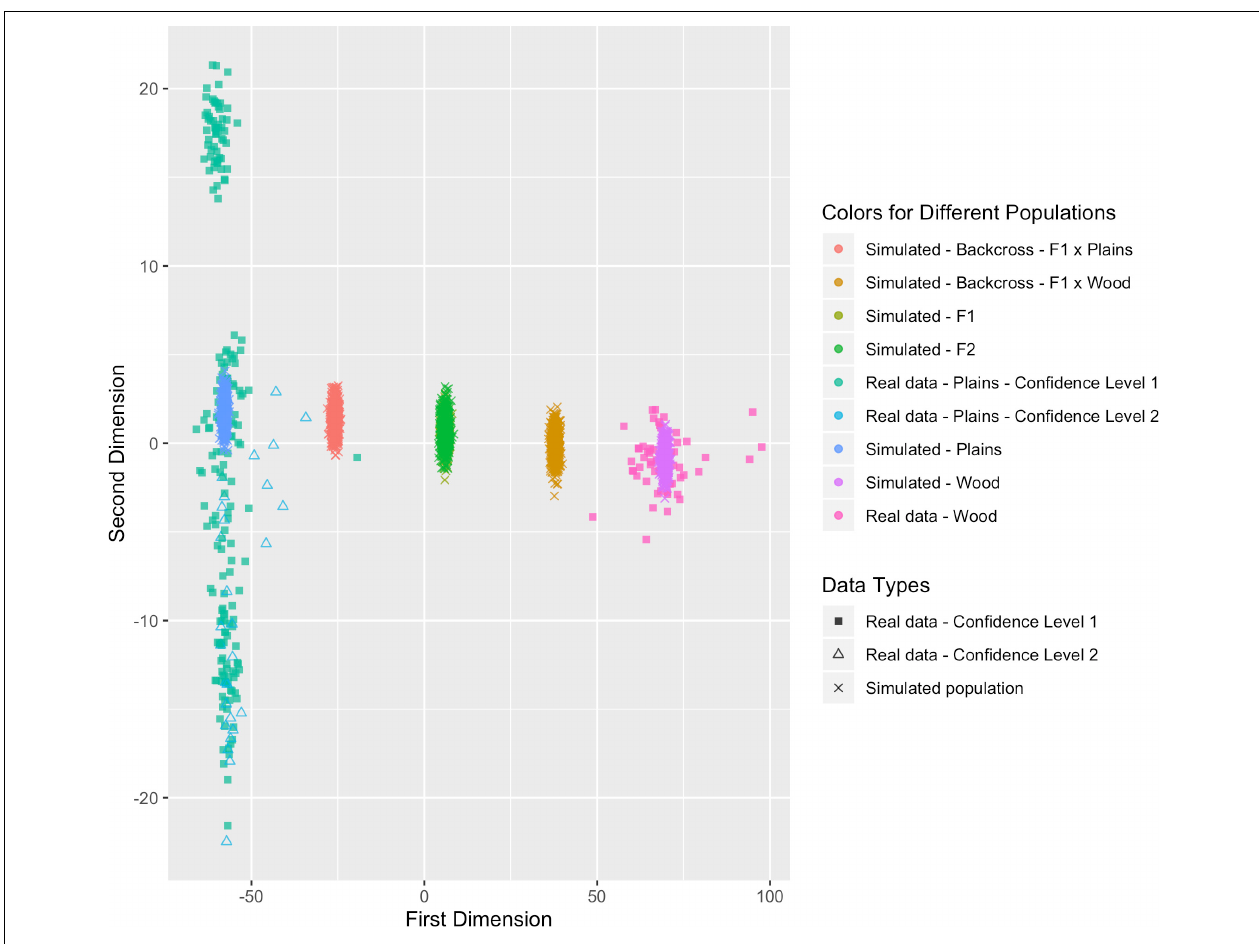
FIGURE 8 | Multi-dimensional scaling (MDS) visualization of genetic distances between simulated populations determined using the custom